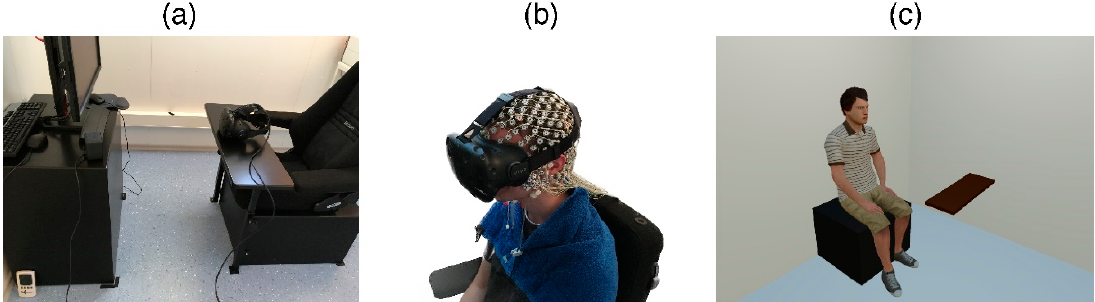
Figure 2. （ a ） : laboratory where the experiment took place. （ b ） : participant equipped with EEG net and VR head-mounted display (HMD). （ c ） : virtual reconstruction of the laboratory with exemplary stimulus.